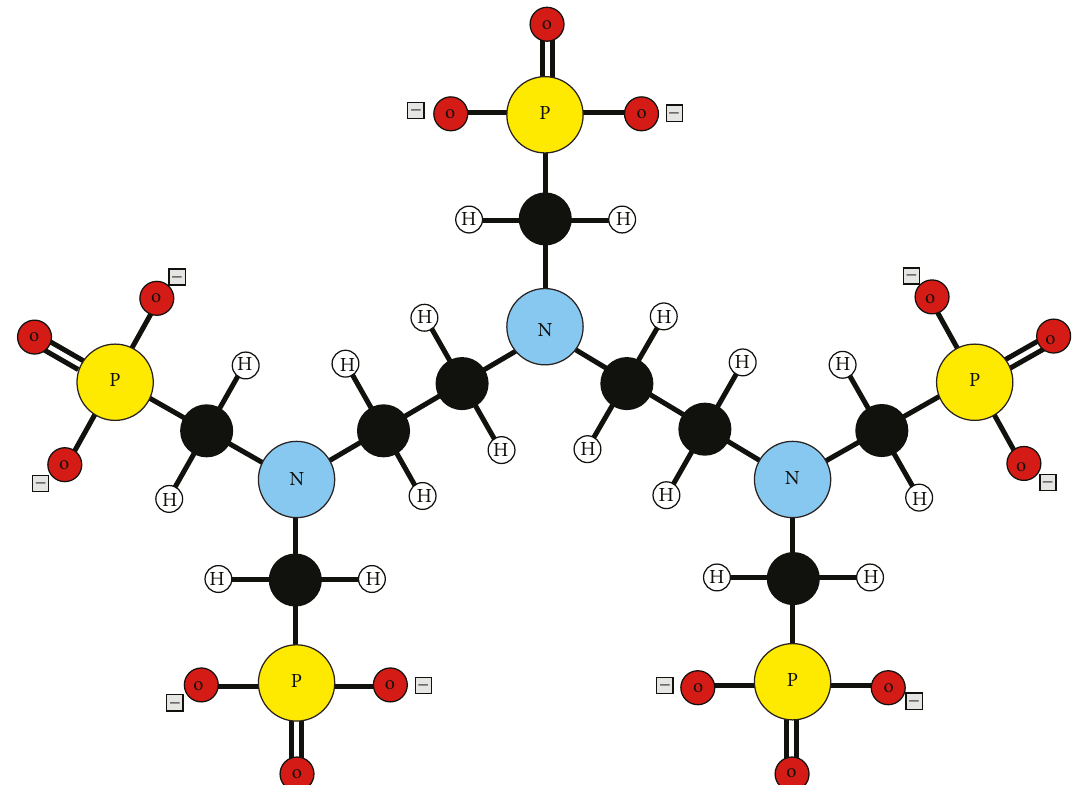
Figure 7: Schematic structure of DTPMP fully deprotonated anion, with 10 negative charges — black circles represent carbon atoms [33]. Table 7: Results of phosphonate monitoring (2010), after [9]. Measuring point (Figure